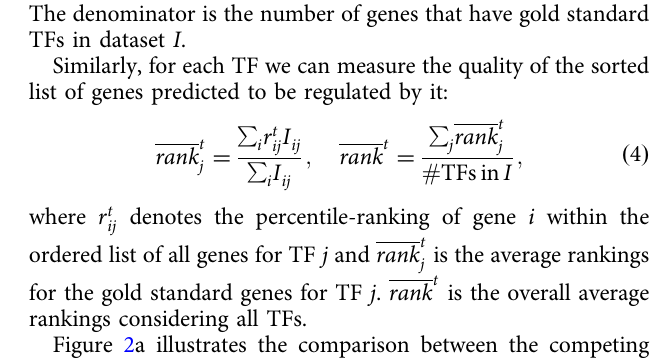
The last four columns show overlap between different networks and parentheses show the corresponding percentage. YEASTRACT is the gold standard network we used for performance